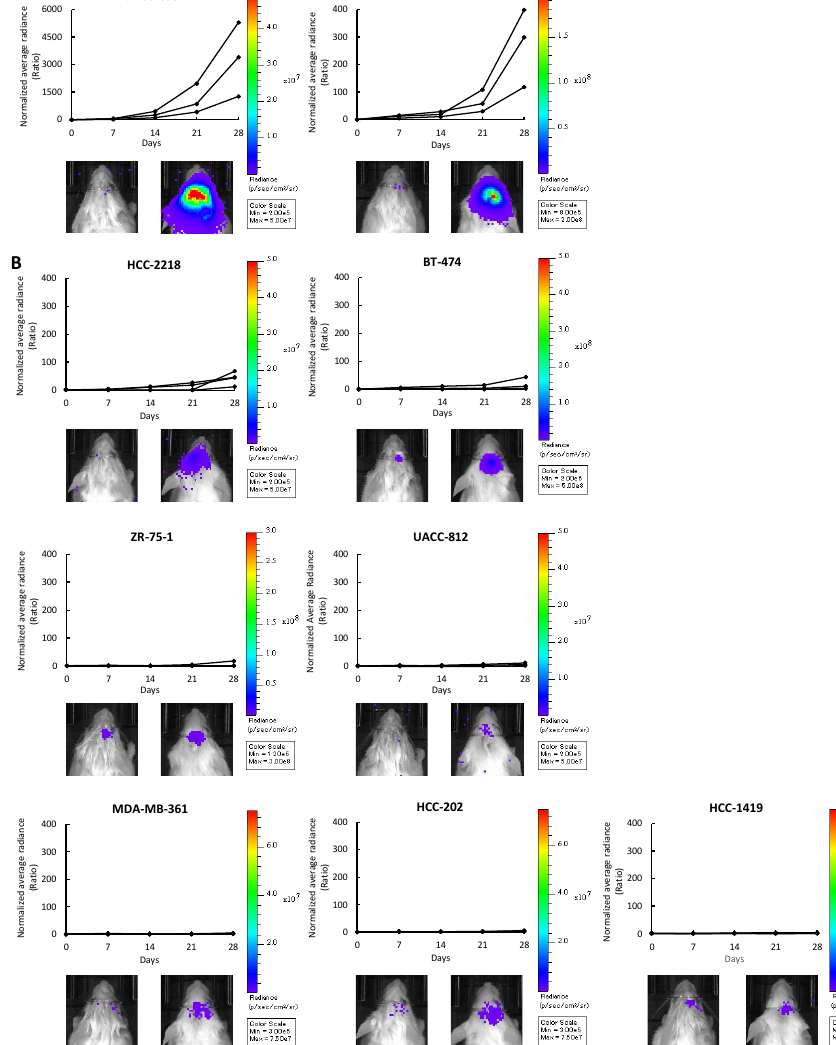
Figure 1. Intracranial injection of nine HER2-positive breast cancer cell lines. UACC-893-luc2, MDA-MB-453-luc2, HCC-2218-luc2, BT-474-luc2, ZR-75-1-luc2, UACC-812-luc2,